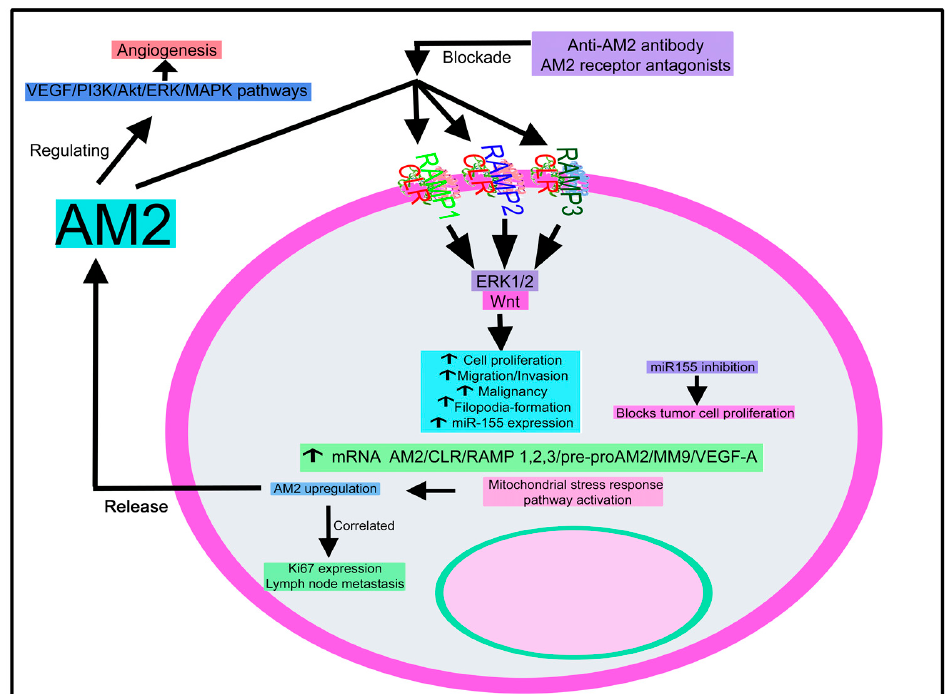
Figure 14. Summary of the mechanisms mediated by adrenomedullin (AM) in tumor cells. AP1: activator protein 1; cAMP: cyclic 3 ′ -5 ′ adenosine monophosphate; CLR: calcitonin receptor-like receptor; EMT: epithelial-to-mesenchymal transition; FAK: focal adhesion kinase; JNK: c-Jun N- terminal kinase; INF γ : interferon γ ; IL-1 β : interleukin 1 β ; RAMP2/3: receptor activity modifying protein 2 and 3; VEGF: vascular endothelial growth factor. ↑ : increase; ↓ : decrease.